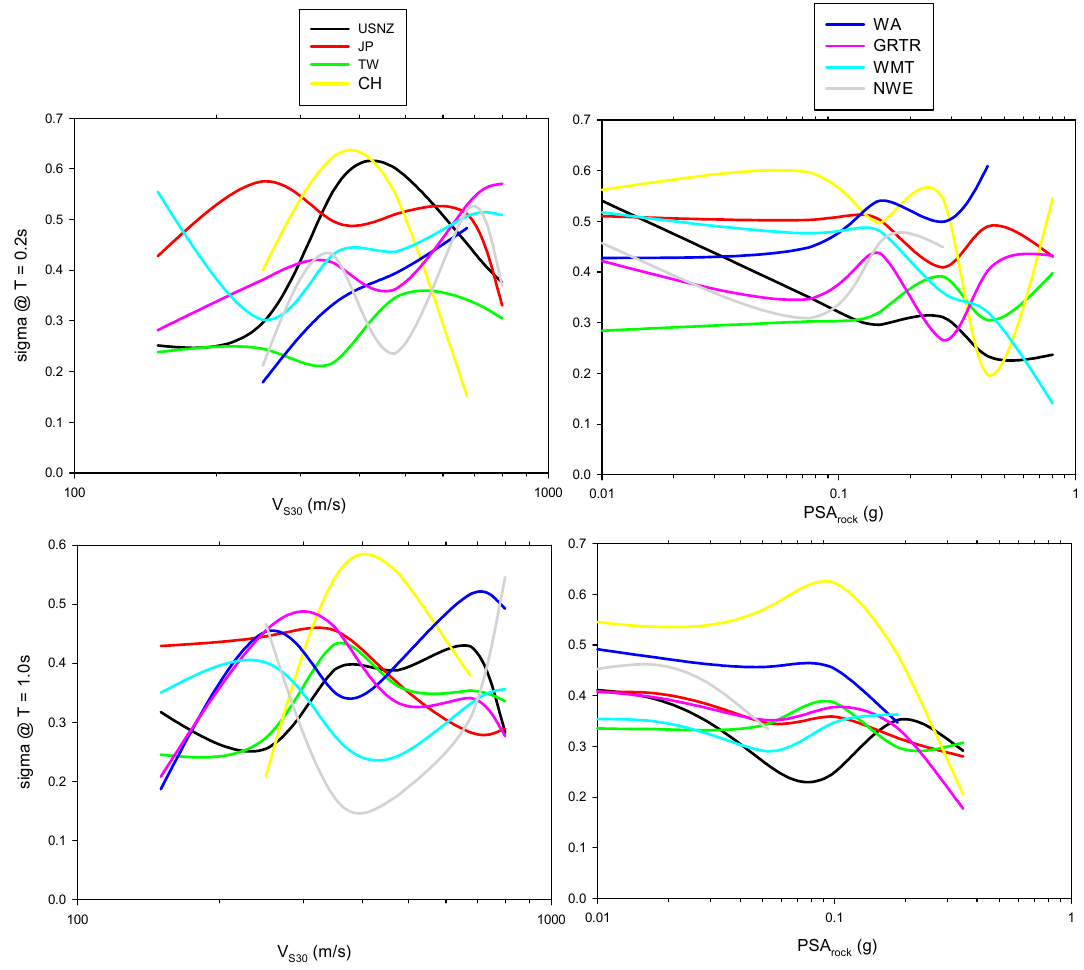
Figure 10. Variability of site amplification for V S 30 and PSA rock at T = 0.2 s and 1.0 s. The site bins are: very soft sites ( V S 30 ≤ 200 m/s), soft sites (200 < V S 30 ≤ 300 m/s), stiff sites (300 < V S 30 ≤ 400 m/s), moderate stiff sites (400 < V S 30 ≤ 550 m/s), very stiff sites (550 < V S 30 ≤ 800 m/s), and rock sites ( V S 30 > 800 m/s). The input rock motion bins for T = 0.2 s are: very weak motion ( PSA rock < 0.05 g), weak motion (0.05 ≤ PSA rock < 0.15 g), moderate motion (0.15 ≤ PSA roc k < 0.45 g), strong motion (0.45 ≤ PSA rock < 0.75 g), and very strong motion ( PSA rock ≥ 0.75 g). For T = 1.0 s they are: very weak motion ( PSA rock < 0.01 g), weak motion (0.01 < PSA rock < 0.05 g), moderate motion (0.05 < PSA rock < 0.10 g), strong motion (0.10 < PSA rock < 0.20 g), and very strong motion ( PSA rock > 0.20 g).